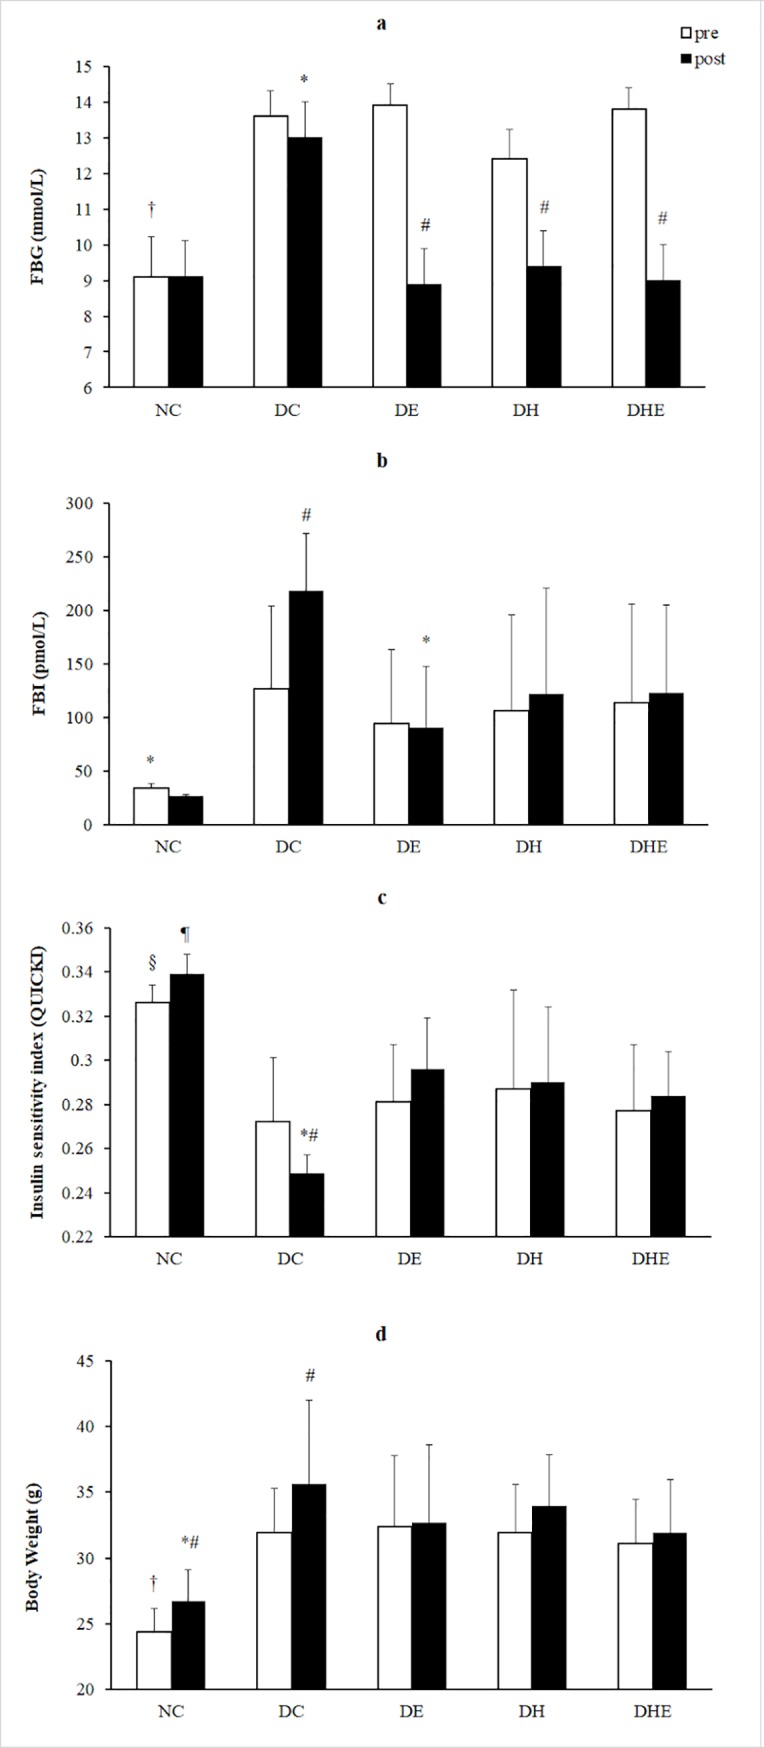
Effects of four weeks intervention on FBG (a), FBI (b), QUICKI (c) and BW (d). Data presented are means with SD. †: p < 0.05, NC vs. diabetes group at pre-treatment. §; p < 0.05, NC vs. DC at pre-treatment. ¶: p < 0.05, NC vs. diabetes group at post-treatment. *: p < 0.05, DC vs. other groups at post-treatment. #: p < 0.05, pre vs. post within group.